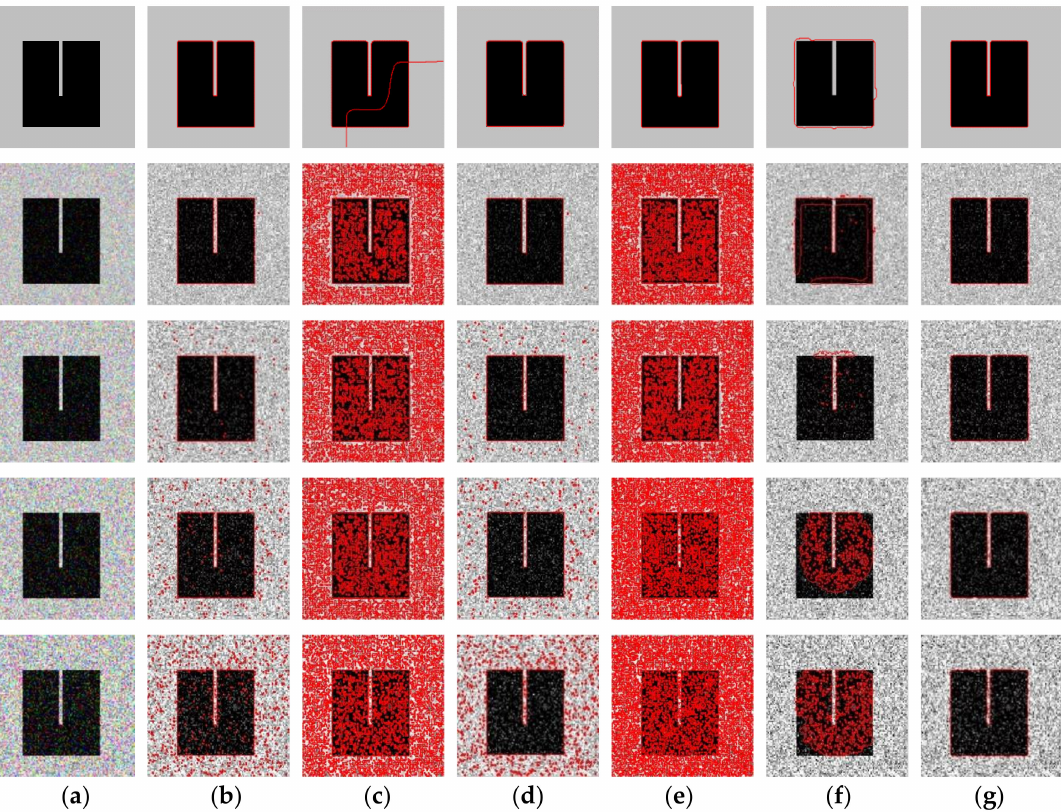
Figure 4. The segmentation results obtained for images with strong noise using the six models. model, and ( g ) SPFLIF-IS